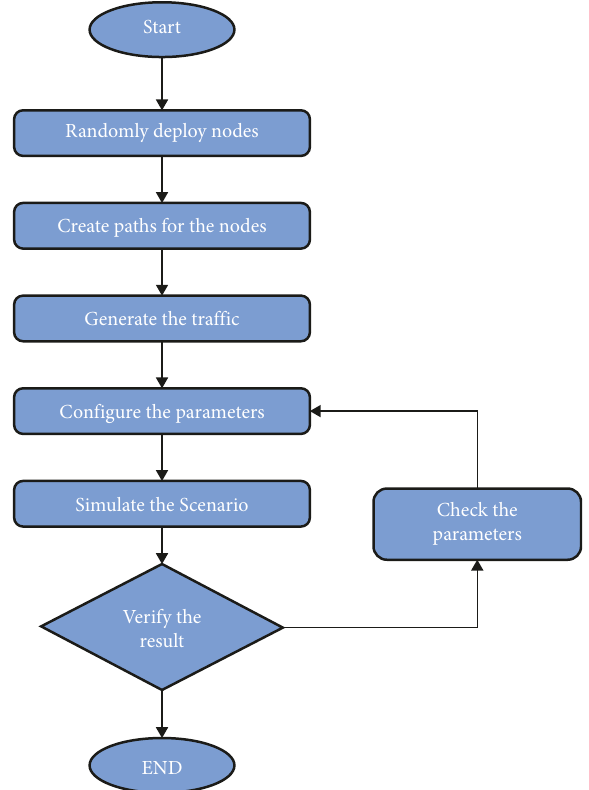
Figure 7: Flow chart of the proposed scenario of